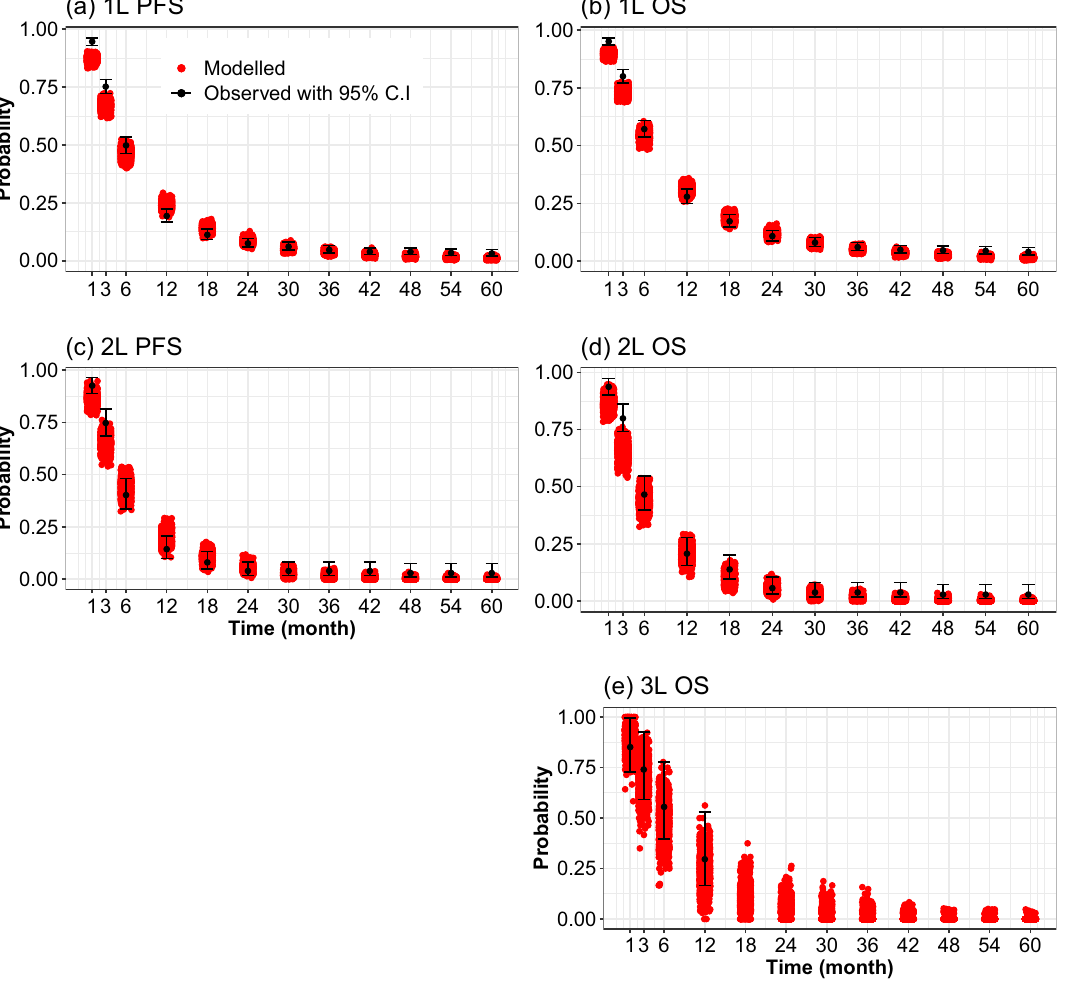
Figure 3. Jitter plot comparing modelled and observed progression-free survival (PFS) and overall survival (OS) probabilities. ( a and b ), PFS and OS from the start of first-line treatment (1L); ( c ) and ( d ), PFS and OS from the start of second-line treatment (2L); ( e ), OS from the start of third-line treatment (3L). The red dots (modelled) refer to the simulated values for a non-personalized treatment strategy where simulated patients are treated with a first-line platinum-based chemotherapy as in the template dataset. The black dots with 95% C.I indicate the point estimates and 95% confidence intervals of observed probabilities from the template dataset (Santeon registry